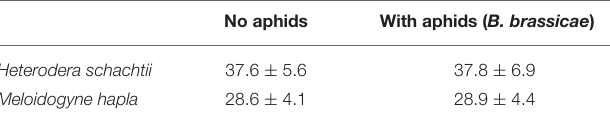
TABLE 2 | Average number ± SEM of cysts ( Heterodera schachtii ) or root galls ( Meloidogyne hapla ) per plant at 16 days after infestation with nematodes on plants with and without 9 days of aphid ( Brevicoryne brassicae )